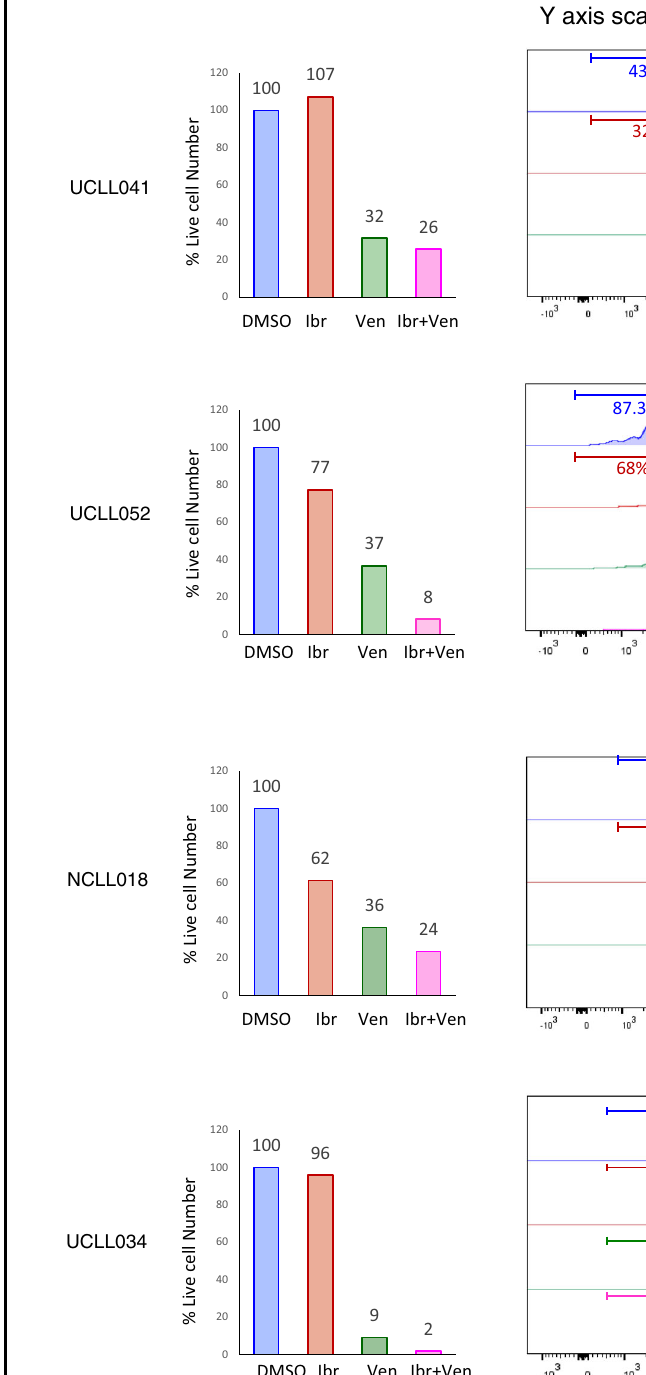
Fig. 5 Combination of ibrutinib and venetoclax effectively eliminates both resting and dividing CLL subpopulations in ibrutinib-resistant cases. Live cell numbers and CFSE pro fi les of four ibrutinib-resistant cases are shown. Experimental conditions were identical to Fig.